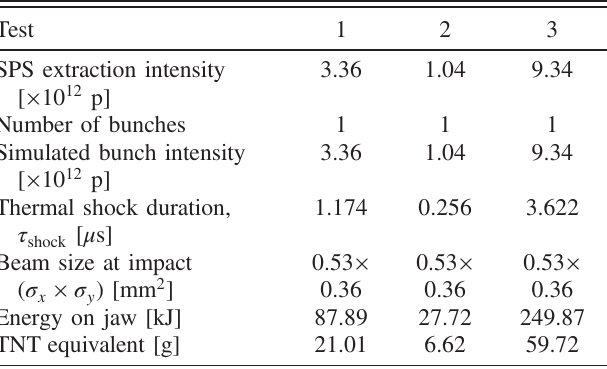
TABLE VI. Summary of the test parameters as simulated by ANSYS ® .